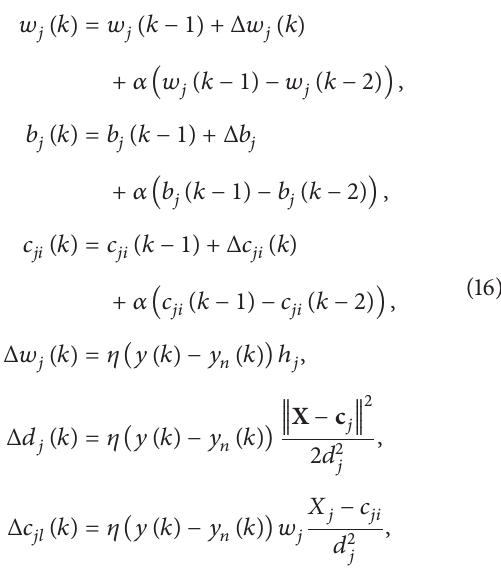
According to the principle of the gradient descent, the iteration algorithm to calculate the variation of the weight of the output layer, the center node, and the node based parameters could be expressed as